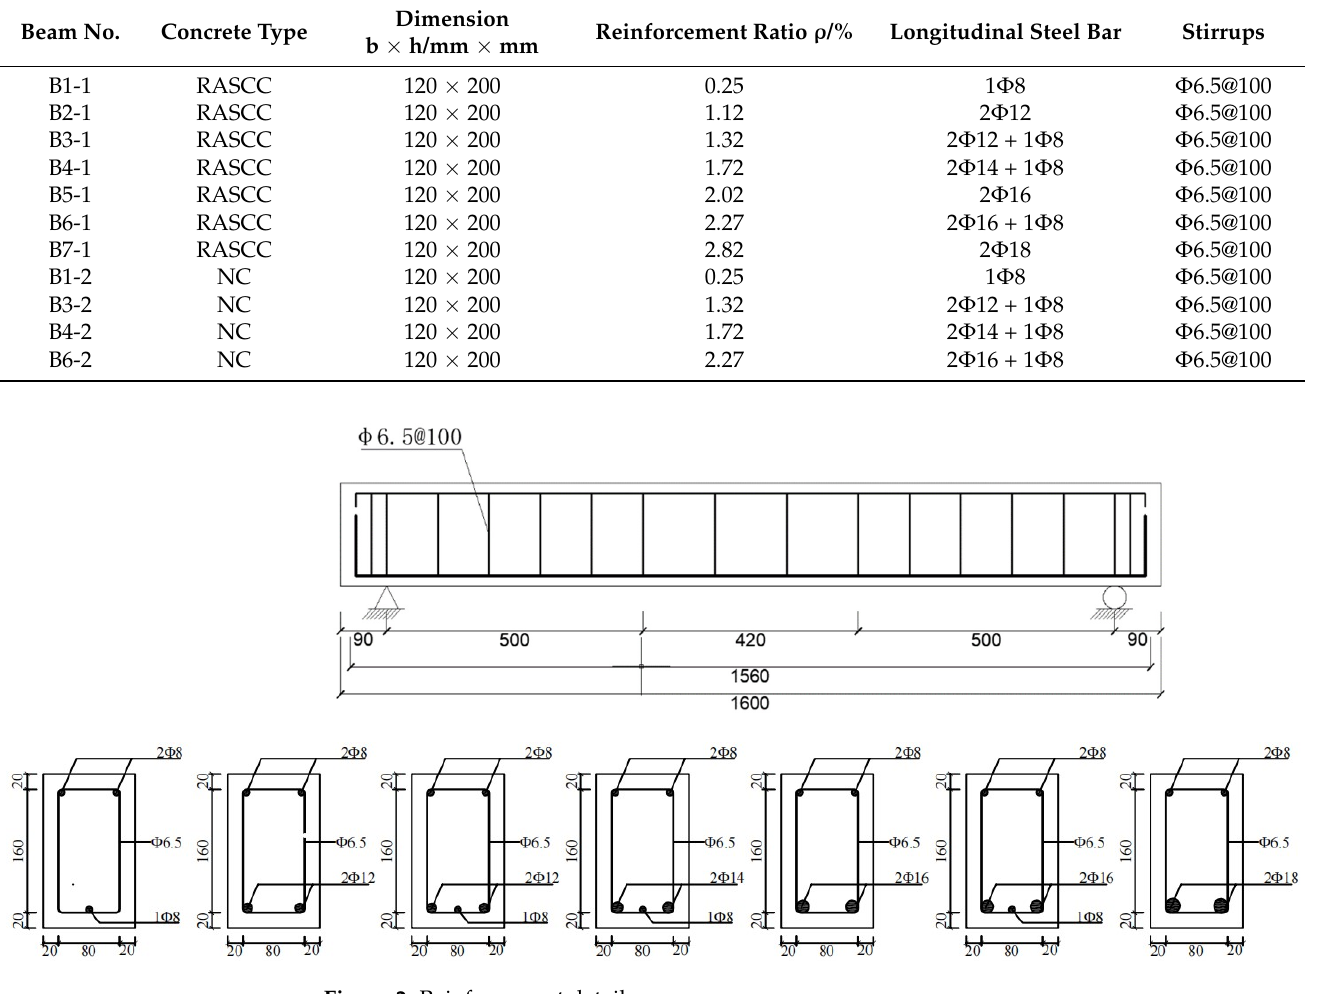
Figure 2. Reinforcement